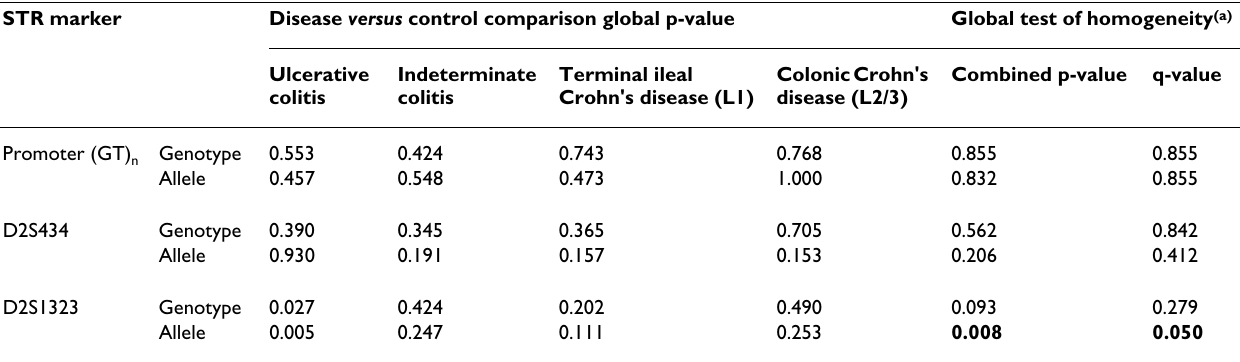
Table 3: Case-control association global q-value and p-values for disease group v ersus control